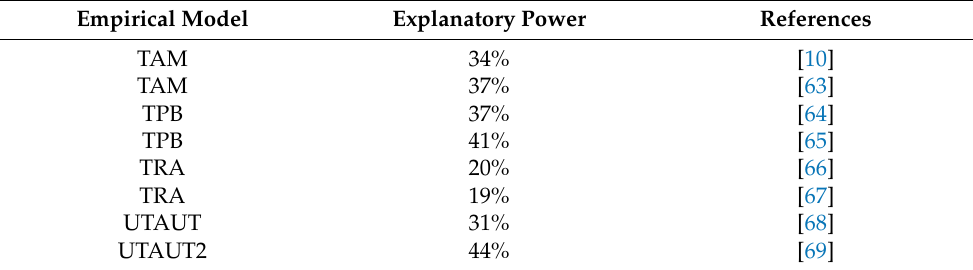
Table 4. The statistical explanatory power for the information technology adoption models. Empirical